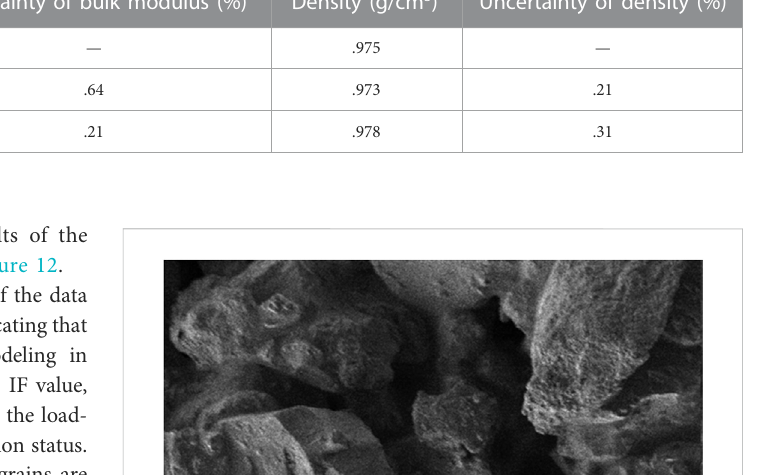
TABLE2Uncertainties ofthe fl uid mixture bulkmodulus anddensity. Theuncertaintiesarecalculated bycomparing themodulusanddensityvalueswiththevaluesat 58% saturation. Oil saturation (%)